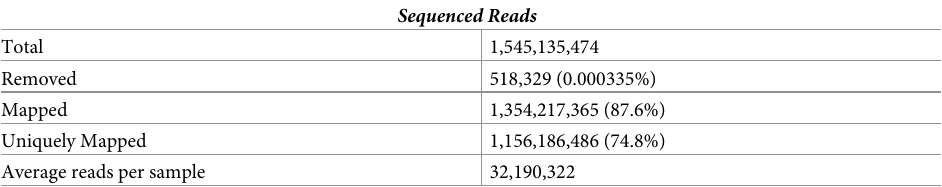
Table 1. Summary of sequencing results from gill (1 dpe) and intestine (7 dpe) of both resistant and susceptible